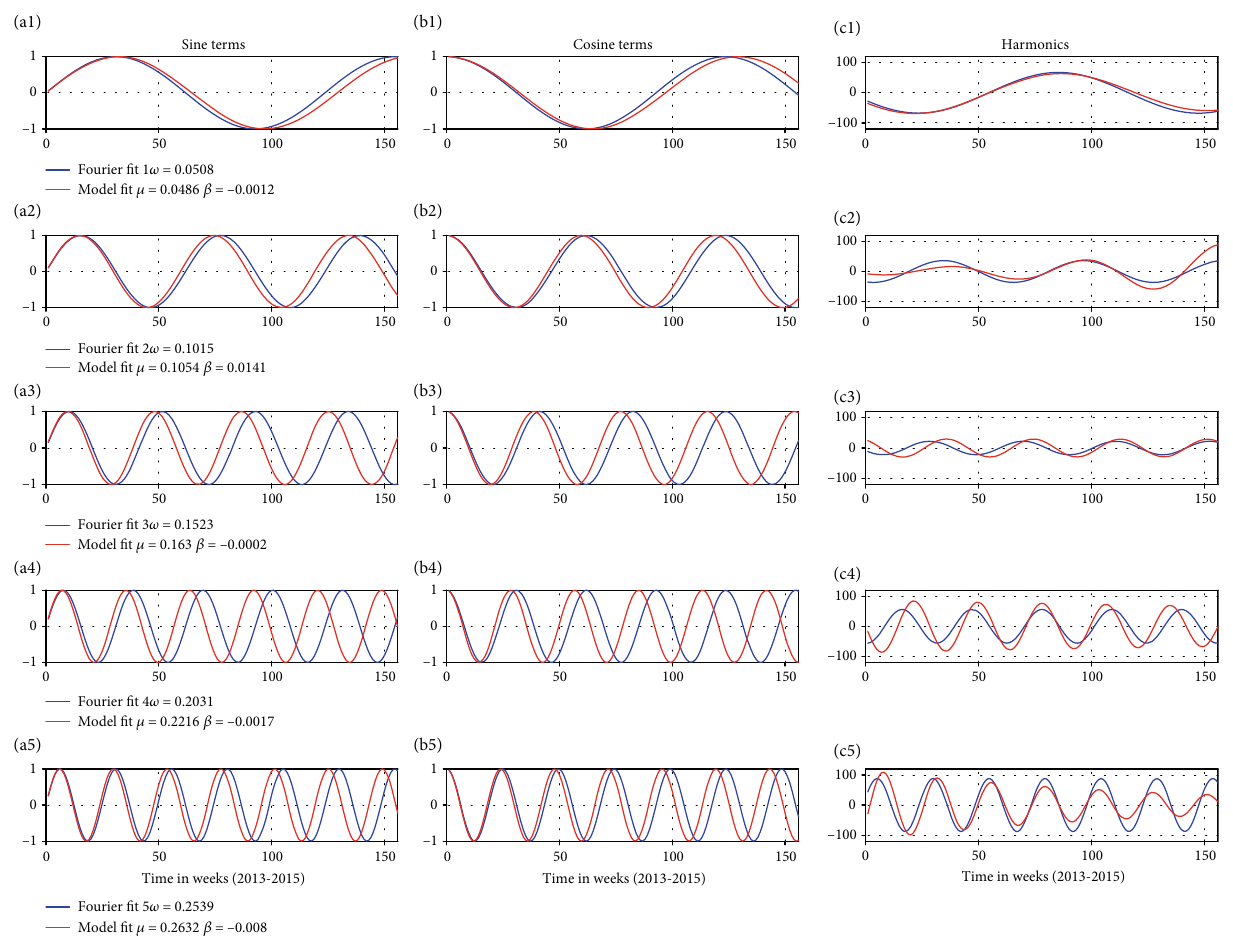
m = 5 . (a ), (b ), and (c ) 0 ) for i i i λ P and n λ Q . 0 0